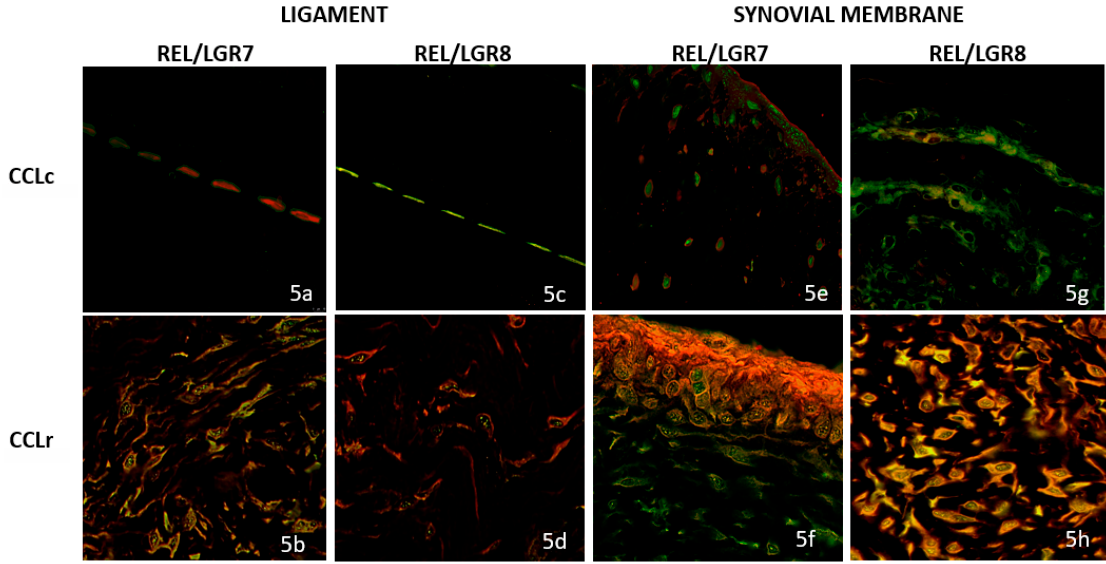
Figure 5. Double immunofluorescence (IF) staining: relaxin = cytoplasmic red IF; LGR7 = (membranous green IF) relaxin/LGR7 co-localization = membranous yellow IF, and relaxin/LGR8 = cytoplasmic yellow IF; for textual explanation see Results above; CCLc = control dog ligaments in ( a , c ), and normal synovial membranes in ( e , g ); CCLr ruptured ligaments in ( b , d ), and altered synovial membranes of dogs with CCLr in ( f , h ). Full original blots can be found in Figure S1.